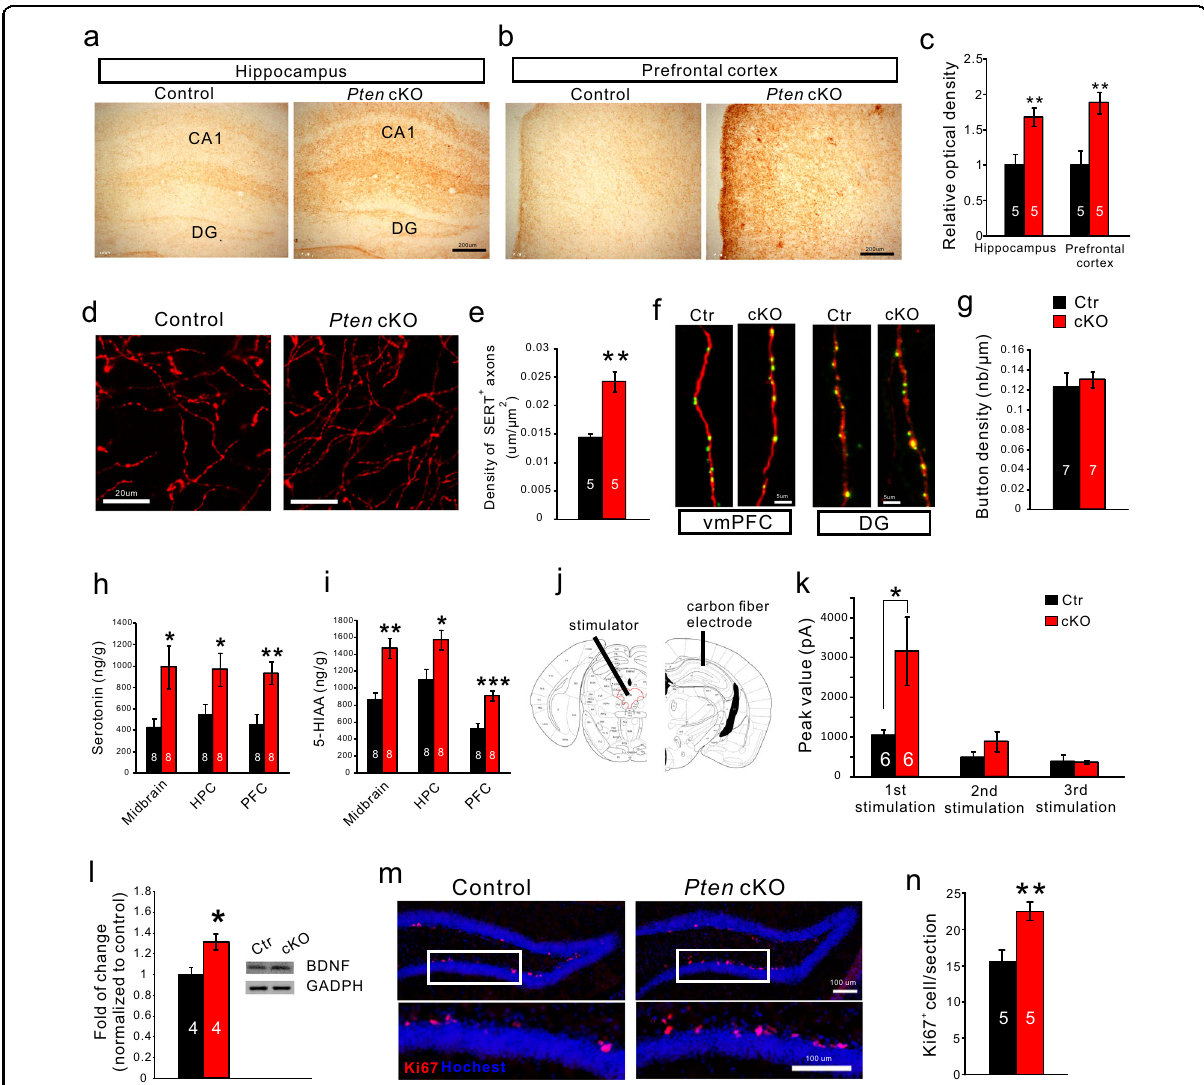
Fig. 4 The increase of 5-HT innervation and axonal release of 5-HT in Pten cKO brain. a , b . SERT + axons/terminals visualized with diaminobenzidine as chromogen in the hippocampus and prefrontal cortex in control and Pten cKO mice. Scale bars = 200 μ m. c SERT + axons/ terminals shown by optical density are increased in the two regions of Pten cKO mice relative to control. d , e High magni fi cation of SERT immunostaining shows individual axons/terminals in the prefrontal cortex ( d ) and comparison of the density of SERT + axons/terminals there ( e ). f Images showing synaptophysin-fused EGFP-labeled buttons within tdTomato-labeled 5-HT axon terminals in the ventromedial prefrontal cortex (vmPFC) and dentate gyrus (DG). g . The density of EGFP-labeled buttons within tdTomato-labeled terminals in the ventromedial prefrontal cortex is similar between Pten cKO and control mice. Scale bars = 5 μ m. h , i 5-HT, and its metabolite 5-HIAA are increased in the midbrain, hippocampus (HPC), and prefrontal cortex (PFC) of Pten cKO mice relative to control. j , k Electrical stimulation of the dorsal raphe nucleus elicits increases of 5-HT release in the hippocampus of Pten cKO mice compared with controls. l BDNF levels are increased in the hippocampus of Pten cKO mice. m , n The increase of Ki67 + cells in the subgranular zone of the dentate gyrus of Pten cKO mice compared with controls. Scale bars = 100 μ m. Numbers of animal used are indicated. All the data are presented as the mean ± s.e.m. * p < 0.05, ** p < 0.01, *** p <